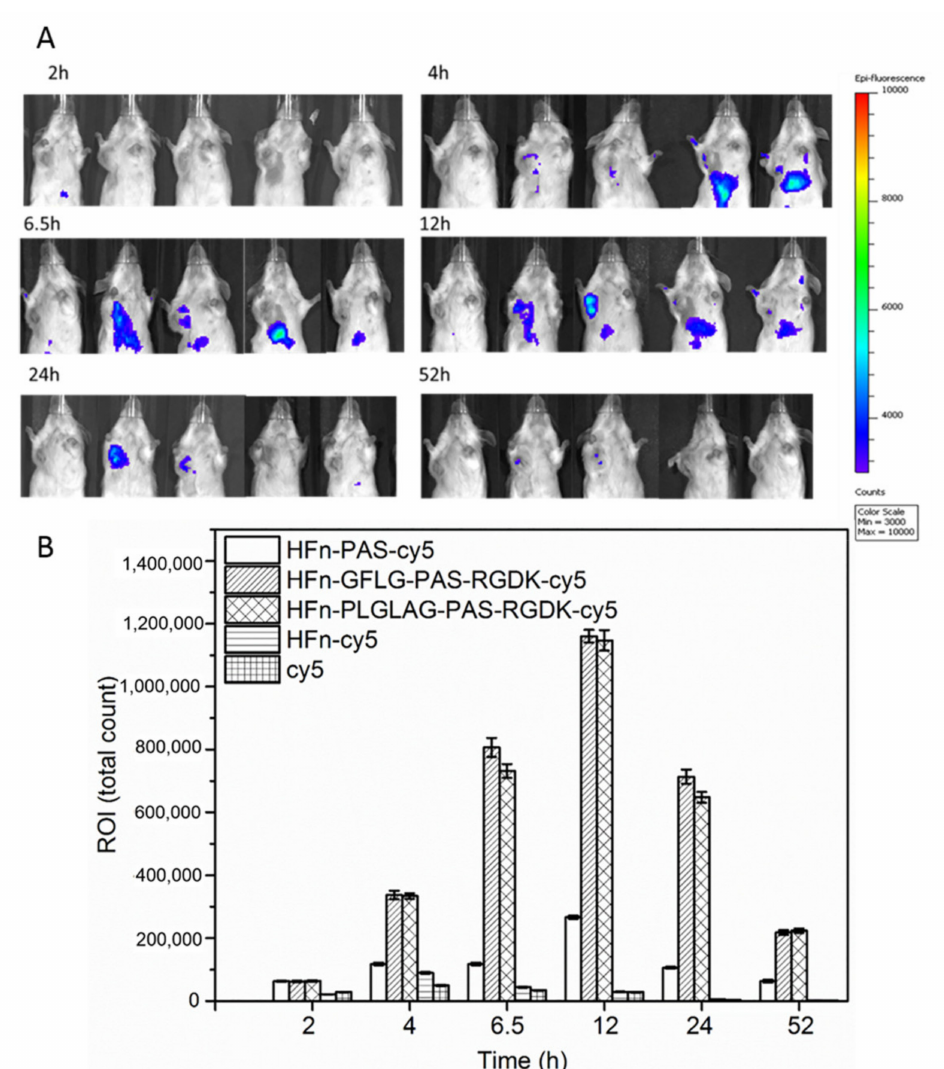
Figure 6. Biodistribution of cy5 and cy5 conjugated with HFn-based proteins. ( A ), in vivo fluo- rescence imaging of tumor-bearing mice at different time points, from left to right: HFn-PAS-cy5, HFn-GFLG-PAS-RGDK-cy5, HFn-PLGLAG-PAS-RGDK-cy5, HFn-cy5 and free cy5. ( B ), the sum fluorescent intensity of region of interest (ROI, tumor area) at each time